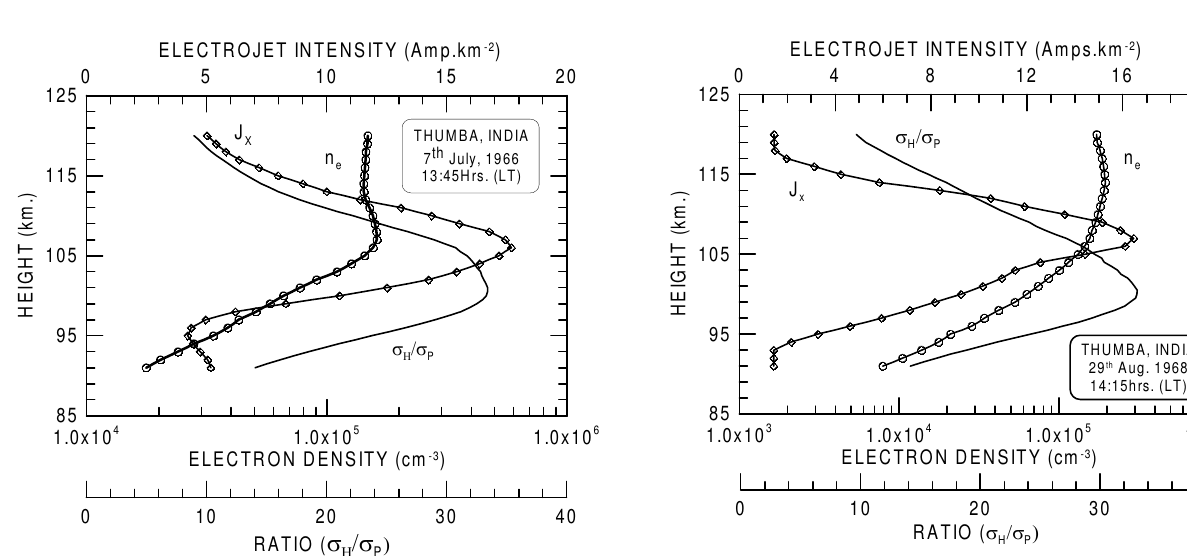
Fig. 1 represents the electrojet currents at 13:45 LT, Fig. 2 those at 11:08 and Fig. 3 those at 14:15, thus representing the daytime electrojet at different intensities compared with its daytime maximum